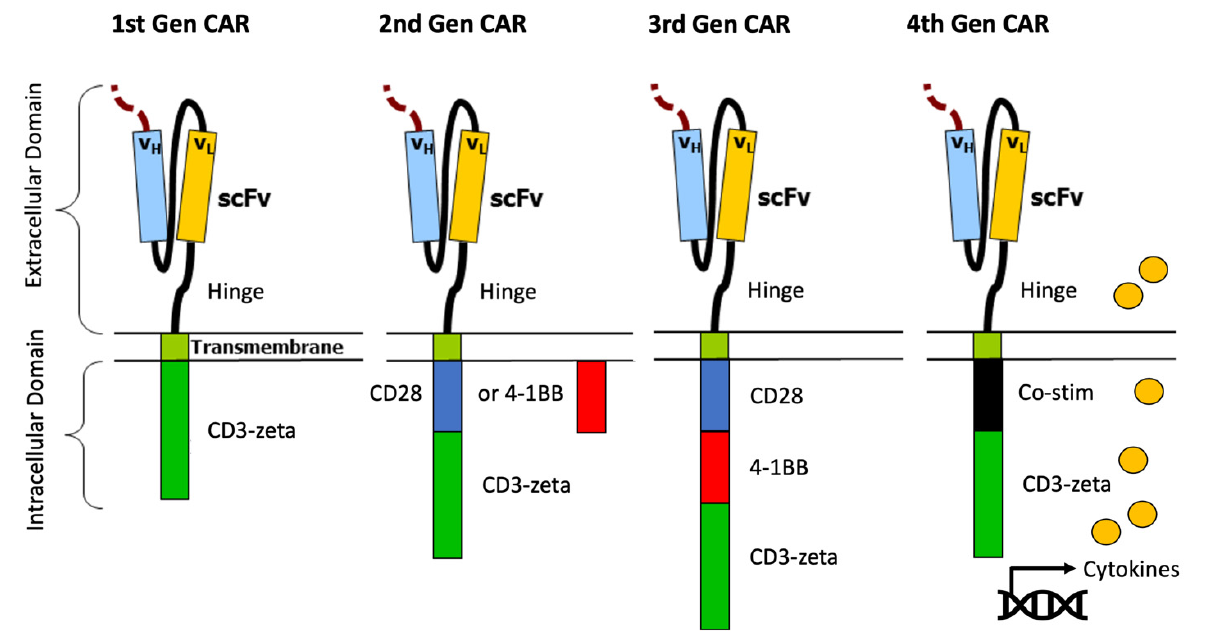
Figure 2. The 1st generation CAR construct includes an extracellular domain with a single-chain variable fragment (scFv) antigen recognition region connected via a hinge and transmembrane domain to the CD3-zeta portion of a TCR. Of note, the scFv is a chimeric protein that includes the variable heavy (VH) and variable light (VL) chains of an immunoglobulin connected via a linker peptide. Second generation CARs include the addition of co-stimulatory domains (CD28 or 4-1BB) to the intracellular domain. Third generation CARs include the addition of a combination of multiple co-stimulatory domains (e.g., CD28 and 4-1BB) to the intracellular domain. Fourth generation CARs include a unique co-stimulatory domain that facilitates increased production of specific cytokines, which augment CAR-T activation and effector functions. Open source image, credit: Mxpule.